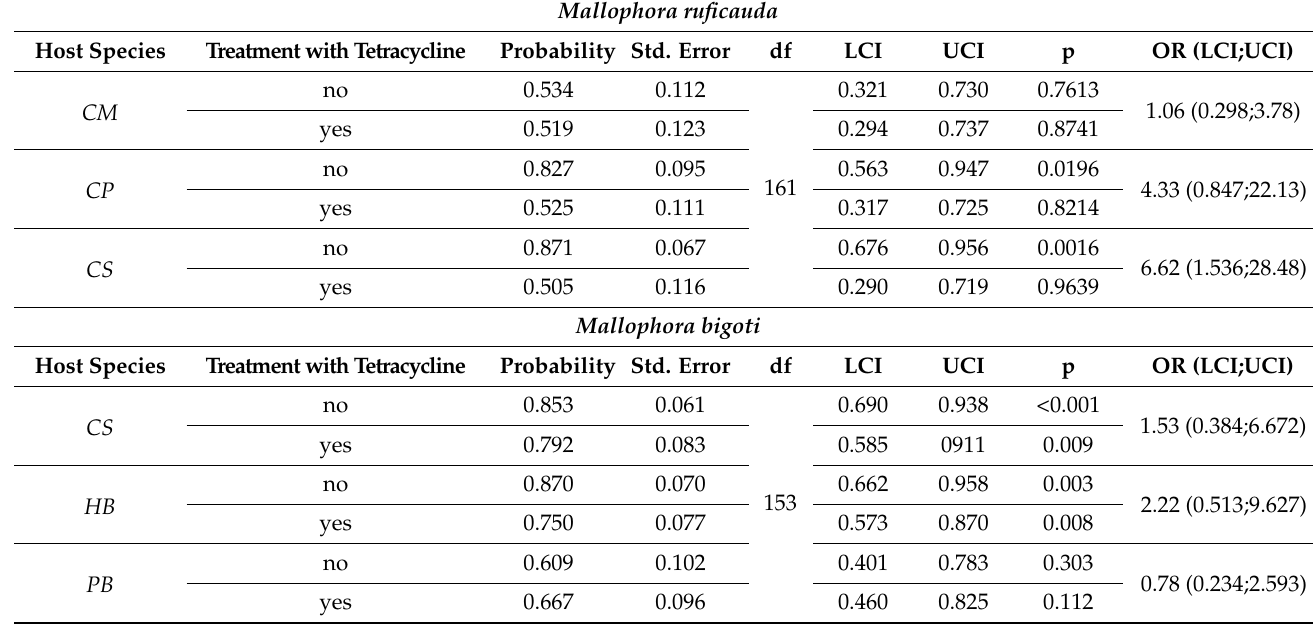
Table 4. Summary of the results of the model for the effect of host species and treatment with tetracycline on the probability of orienting to a host for M. ruficauda and M. bigoti . The first part shows the predicted probabilities and odds ratios for host orientation experiments of M. ruficauda . The inferior part shows the predicted probabilities and odds ratios for host orientation experiments of M. bigoti . CM: Cyclocephala modesta , CP: C. putrida , CS: C. signaticollis , HB: Heterogeniates bonariensis , PB: Plectris bonariensis , df: Degrees of freedom. LCI and UCI: Lower and upper confidence interval for the estimated probability. OR (LCI;UCI): Odds ratio with lower and upper confidence interval for the odds ratio between untreated hosts/hosts treated with tetracycline. It should be noted that if the confidence interval includes 1, the OR is not significant, rendering no difference between groups.